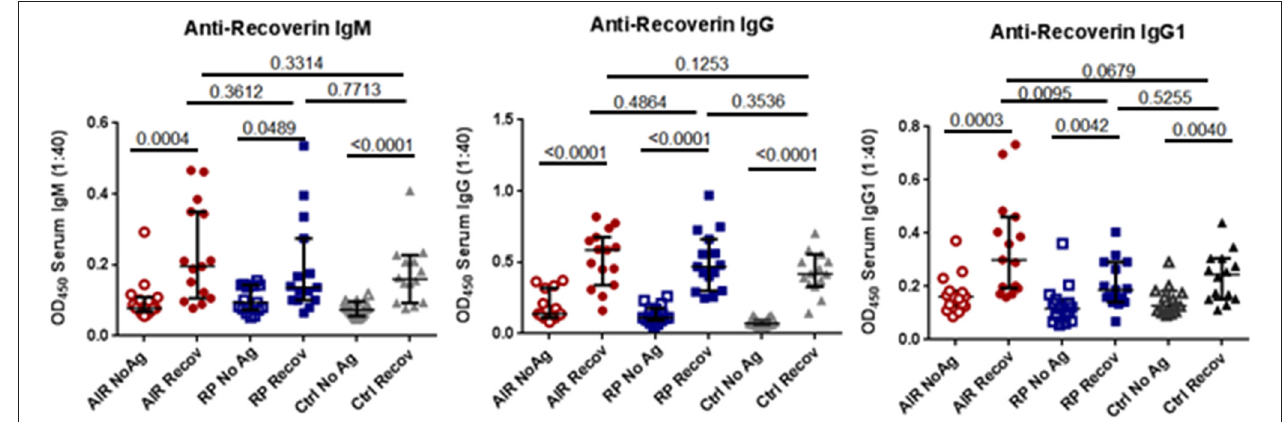
FIGURE 2 | Anti-recoverin antibodies are frequently present in blood of patients and controls. Plasma was separated from heparinized blood of untreated AIR patients ( n = 15), RP patients ( n = 15), and healthy controls ( n = 14). Half of the wells of a flat-bottomed 96 well EIA plate were coated overnight with 2.5 µ g/mL recombinant human recoverin (Recov) in carbonate buffer, washed, and blocked with PBS 2% BSA for 2h. Control wells were similarly treated without addition of recoverin (NoAg). A 1:40 dilution of plasma was added in triplicate to Recov and NoAg wells for each sample for 2h. Plates were then washed and binding of patient antibodies was detected in replicate wells using biotin-conjugated anti-human IgM-, anti-human IgG-, or anti-human IgG1-specific antibodies, followed by addition of streptavidin-HRP and TMB substrate. Each dot represents the mean 450nm absorbance for one individual run in triplicate. Black lines and hash marks show the median and 95% confidence interval for each group and the exact P -values as determined by Mann-Whitney tests are shown for the indicated pairwise